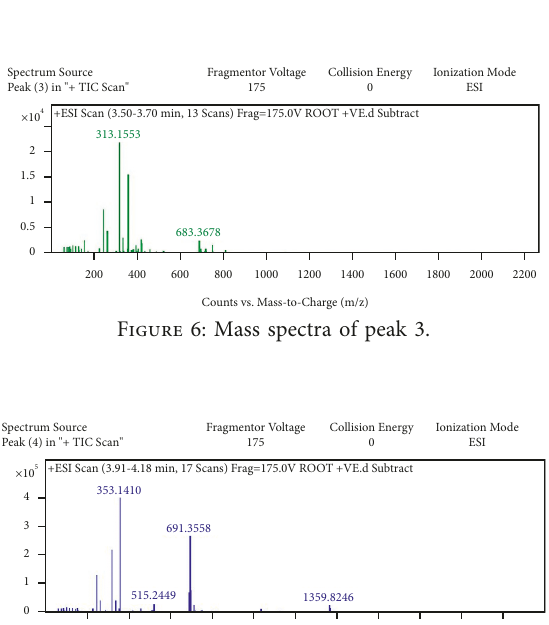
Figure 5: Mass spectra of peak 1.